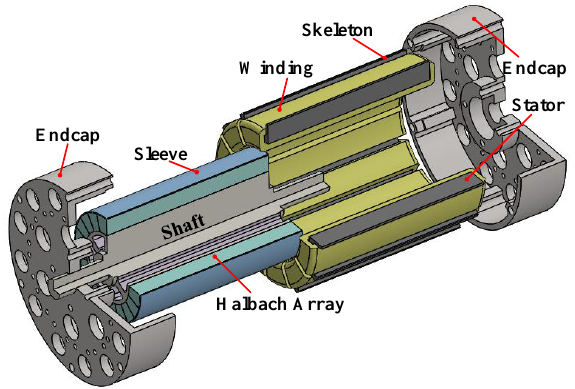
Figure 1. The 3D structure diagram of the SPMM-GRW.